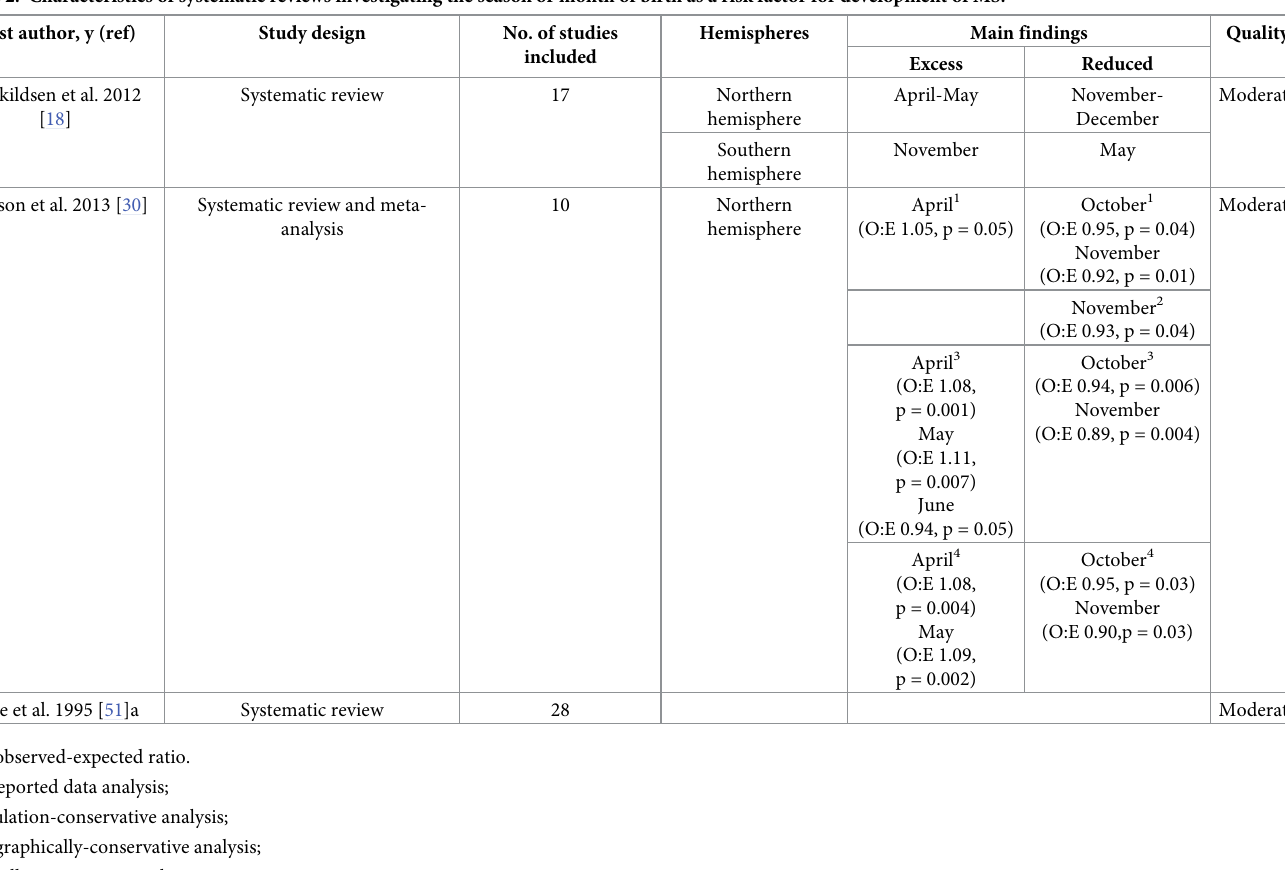
Table 2. Characteristics of systematic reviews investigating the season or month of birth as a risk factor for development of